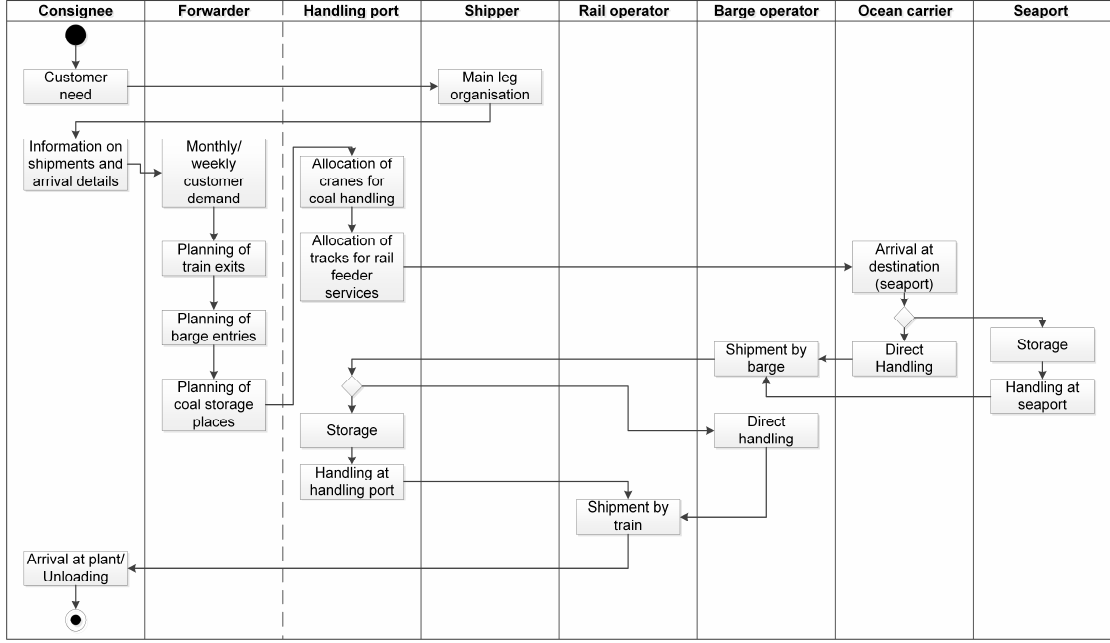
Figure 7. Focus area of the considered transshipment process.